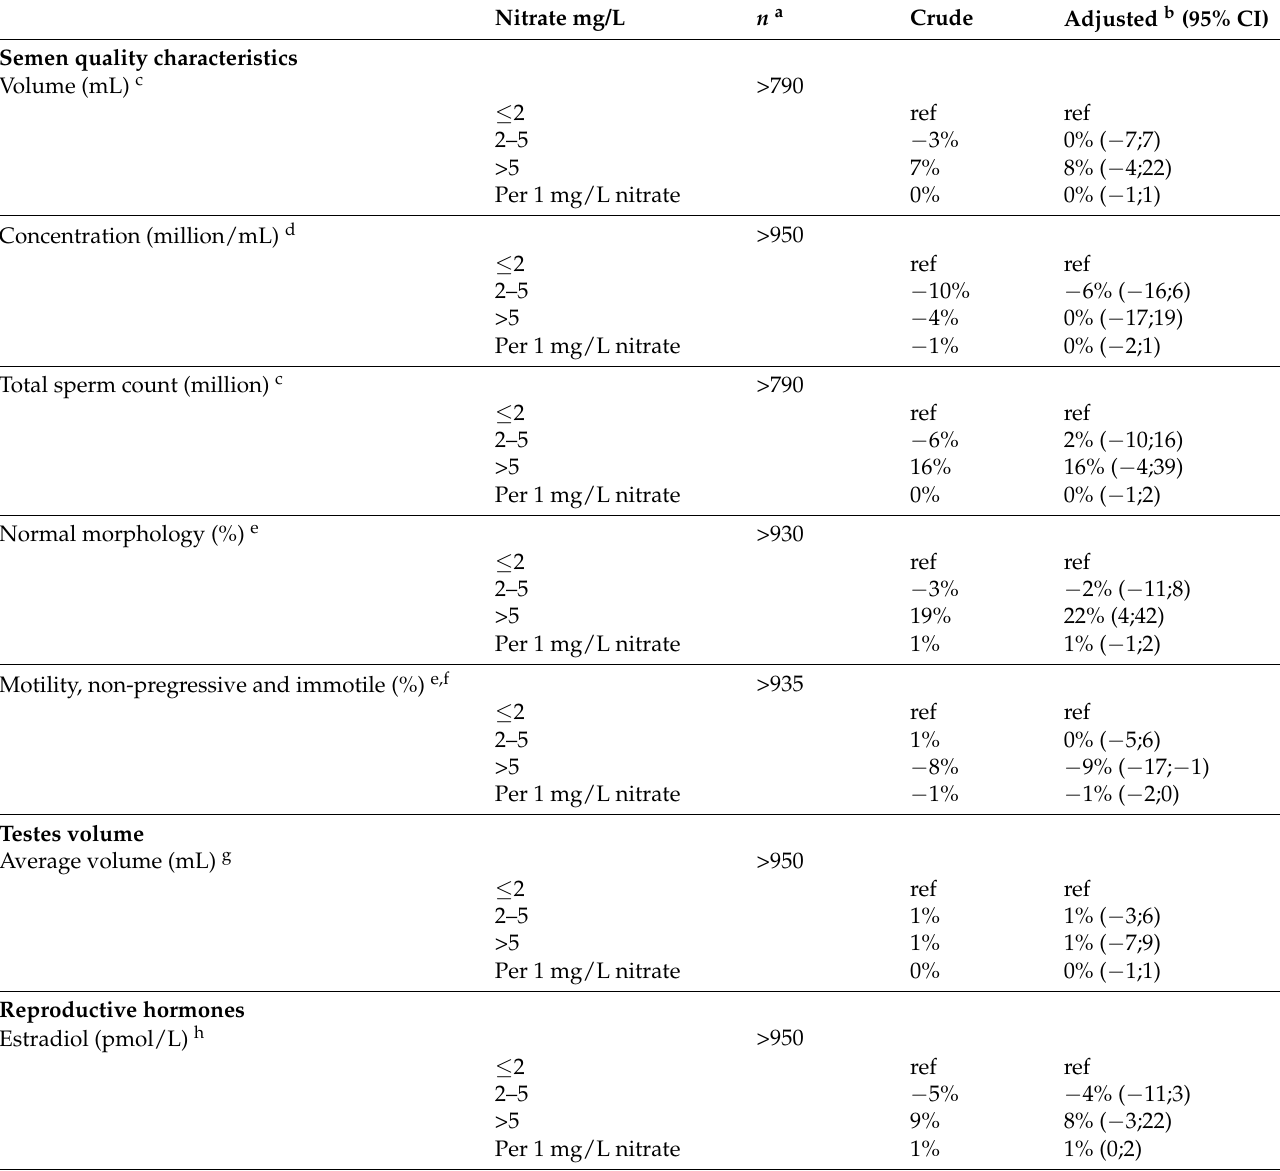
Table 3. Relative difference in percent in semen quality characteristics, testes volume and reproductive hormones in adult sons in relation to nitrate concentration in maternal drinking water. Nitrate mg/L n a Crude Adjusted b (95%